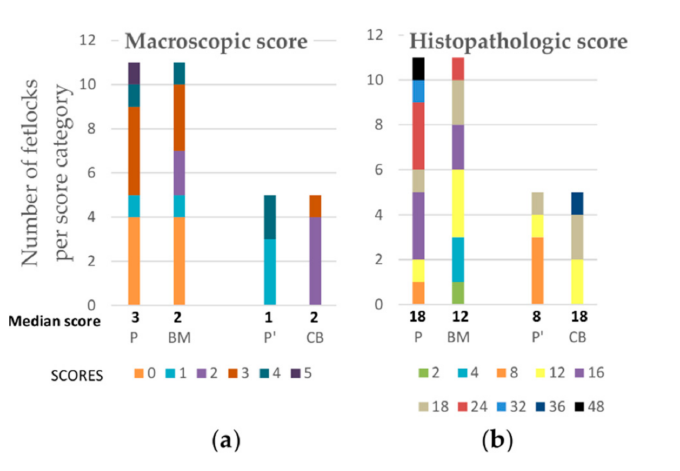
Figure 7. Median post-mortem scores and number of fetlocks per macroscopic ( a ) and histopatholog- ical ( b ) scores obtained on week 12 and displayed per treatment group. P—Fetlocks injected with placebo, contralateral of the fetlocks injected with bone-marrow derived mesenchymal stem cells (BM-MSCs); BM—Fetlocks injected with BM-MSCs; P’—Fetlocks injected with placebo, contralateral of the fetlocks injected with umbilical cord blood derived mesenchymal stem cells (UCB-MSCs); CB—Fetlocks injected with UCB-MSCs.